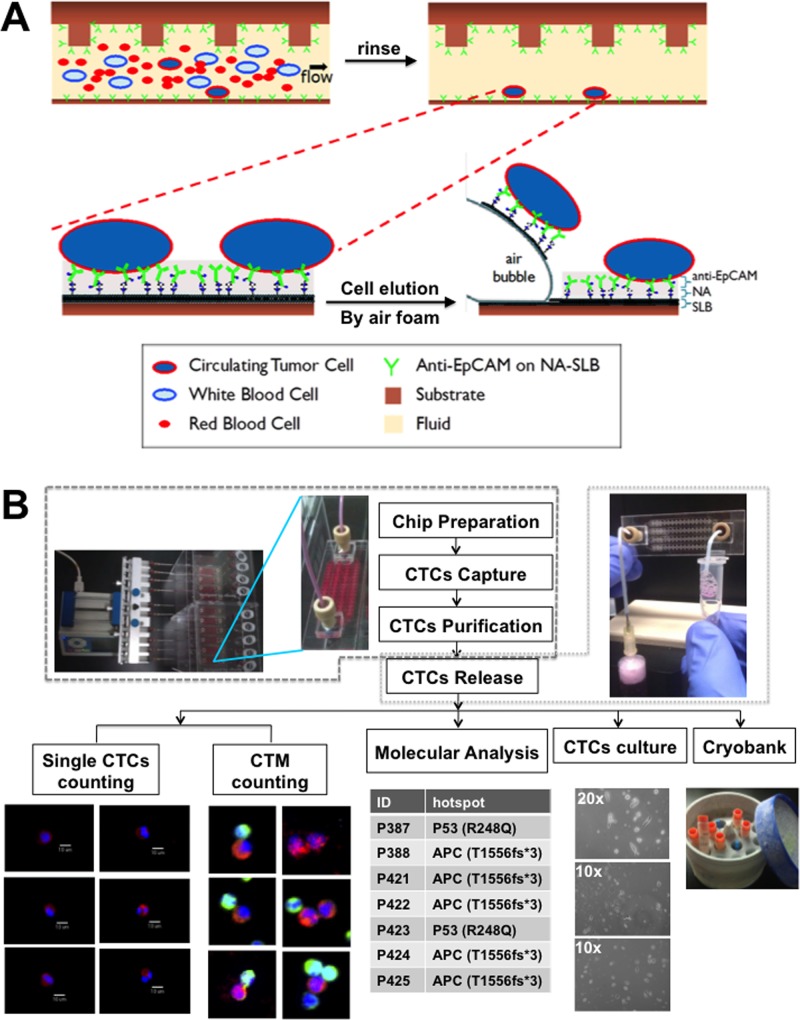
Overview of the CMx platform.(A) Strategies to capture, purify and release CTCs of the CMx platform. In the top row, blood flows through a microfluidic channel coated with anti-EpCAM conjugated to NeutrAvidin which is adhered to a SLB layer on substrate. Selective binding of CTCs to anti-EpCAM is reinforce by the antibody clustering effects through the mobility of the fluidic SLB layer, while other blood cells are easily flush away from the fluidic surface. The bottom row showed the release process, in which introduced air bubbles disrupt the weakest links between substrate and the SLB layer allowing elute intact CTCs for the collection outside of microfluidic chip. (B) Overview of CMx platform and summary of the CMx platform workflow. About 2 mL of the whole blood samples obtained freshly from the CRC patients were loaded equally into each CTC capturing devices. All chips went through cell capture, purification, and released for various downstream applications, including immunofluorescence staining, cell counting, molecular analysis, ex vivo cell culture and/or cryobanking.